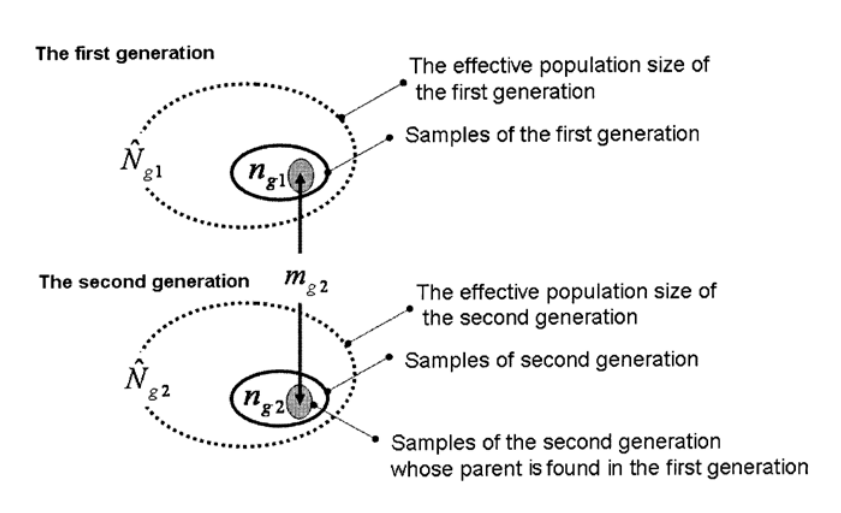
Fig. 1. The concept of the MMR